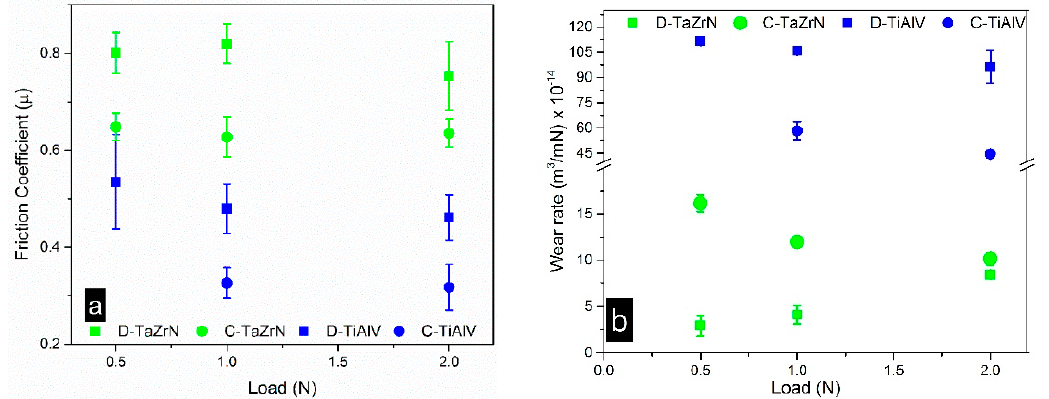
Figure 6. ( a ) Average of the friction coefficients as a function of the applied load; ( b ) wear rate as a function of the applied load for dry (D) and corrosive (C) conditions.